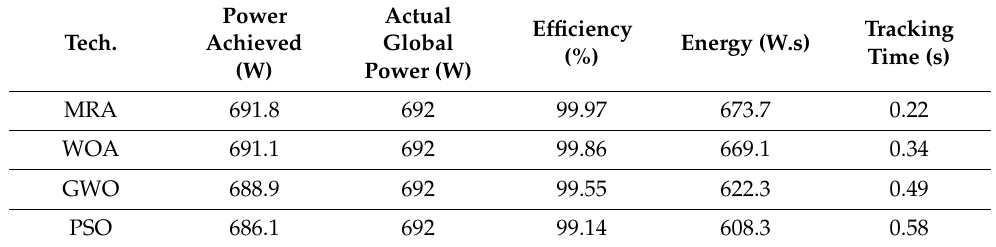
Table 1. Comparative analysis for Case 1.